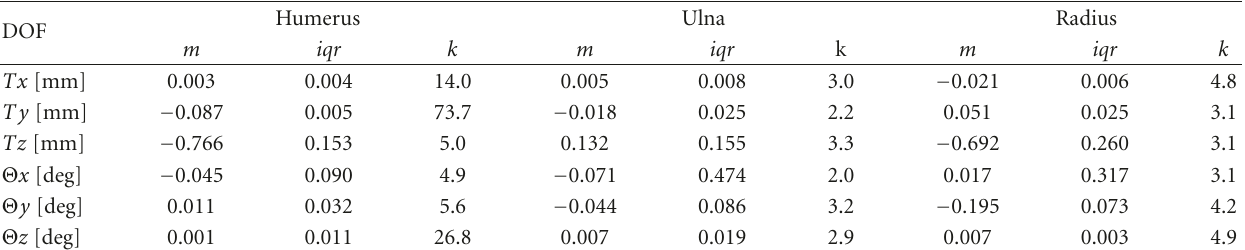
Table 3: Final accuracy in terms of median ( m ), interquartile range ( iqr ) and kurtosis ( k ) of the pose estimations, for the three bone models with the seq-feat